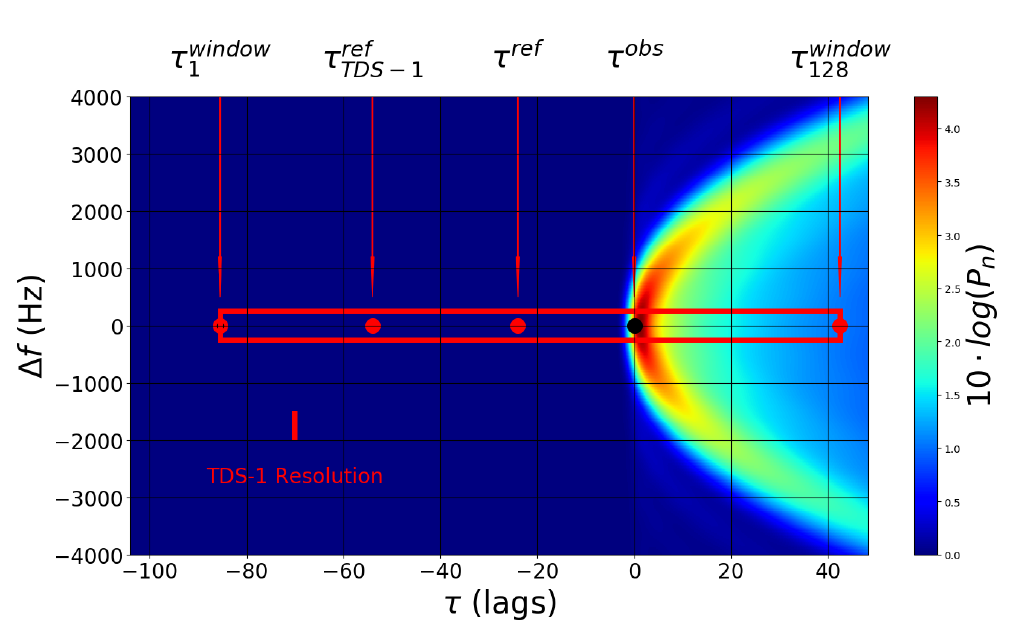
Figure 2. The normalized power P n ( τ , ∆ f ) of a simulated TDS-1 one-second sea DDM, computed with typical values encountered in the TDS-1 situation. The origin of the coordinate system has been assigned to the point corresponding to the observed delay τ obs and ∆ f = 0. The TDS-1 resolution is indicated by the small red box. The larger red rectangle indicates the TDS-1 correlation pixels used in this altimetric study. The beginning and end of the waveform are indicated with the labels τ window and τ window . The point τ ref corresponds to the TDS-1 a priori reference and τ ref is the corresponding 128 TDS − 1 a priori value considered in this